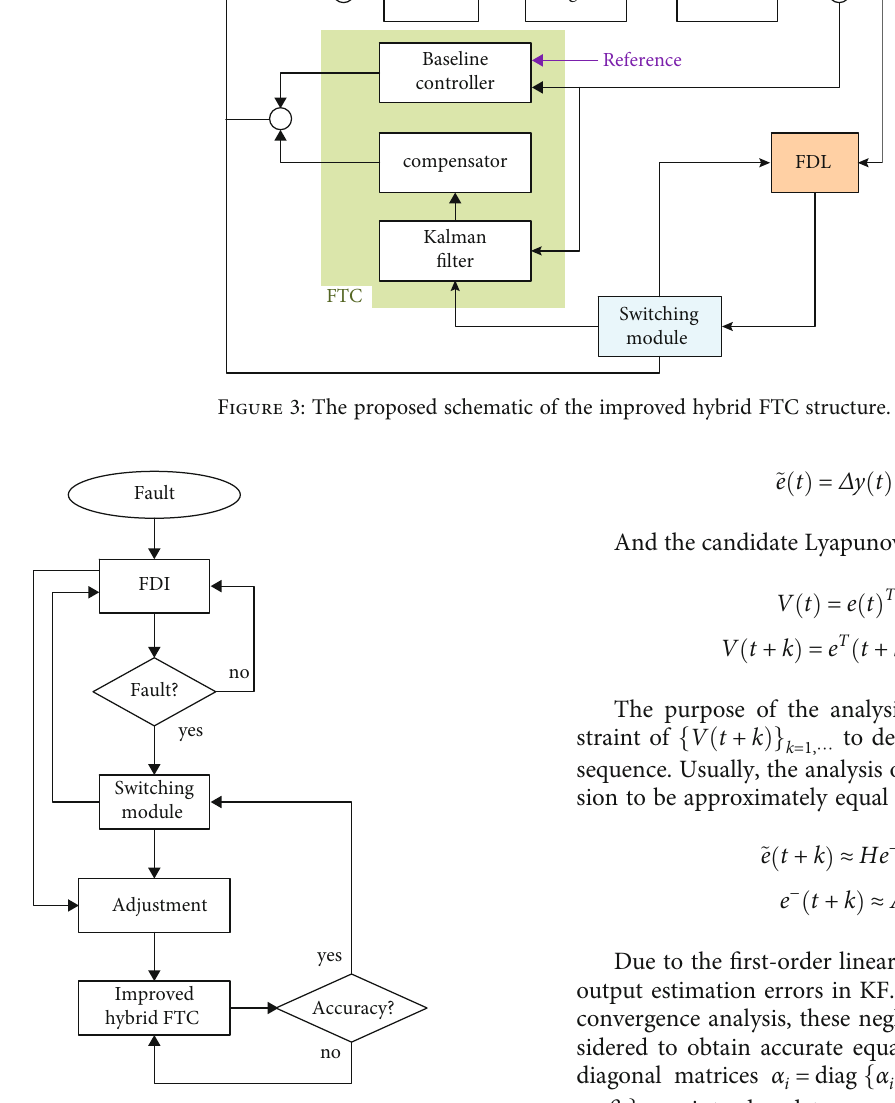
Figure 4: Working process in the improved hybrid FTC